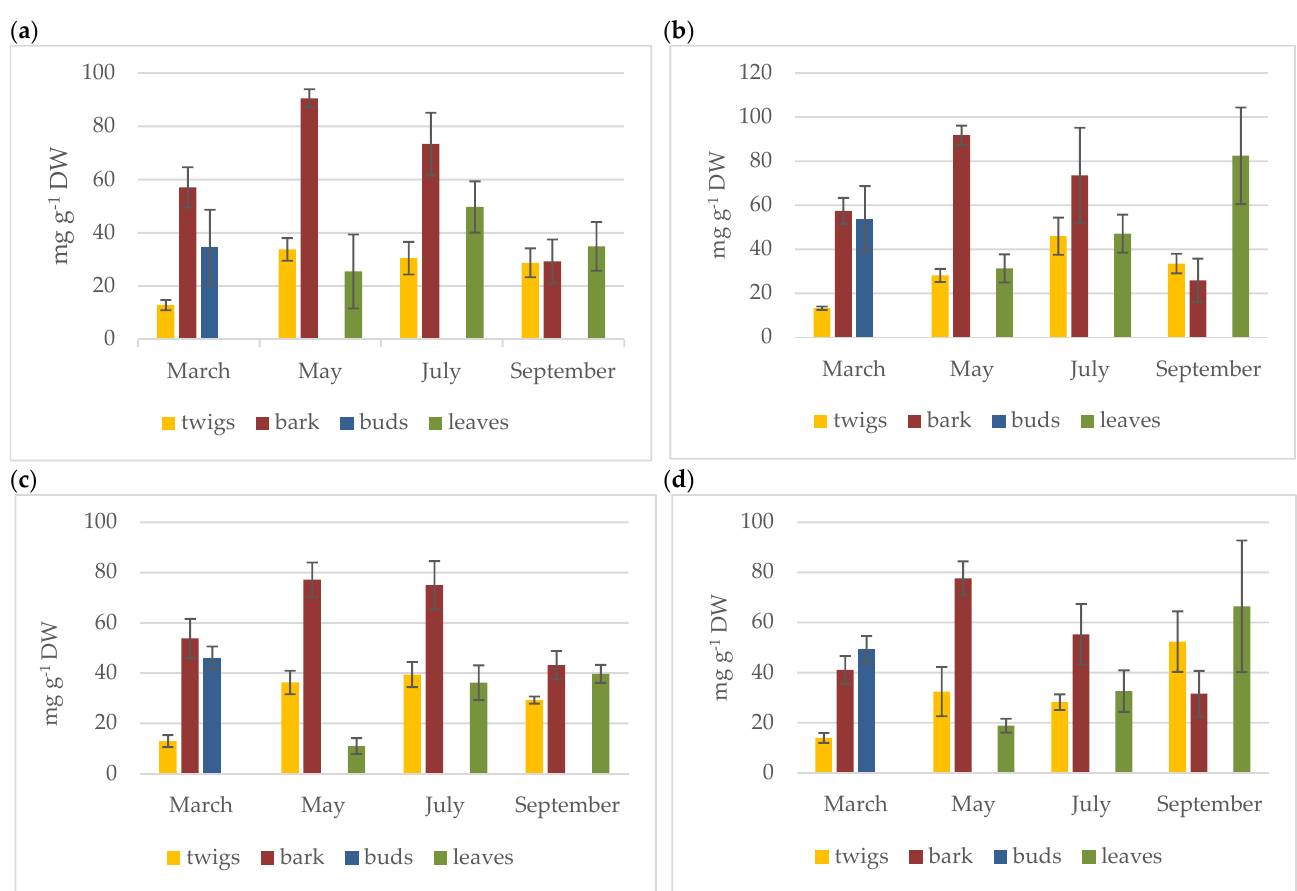
Figure 3. Content of phloridzin in ( a ) cv. ‘Jonagold’, ( b ) cv. ‘Opal’, ( c ) cv. ‘Redlane’, ( d ) cv. ‘Rozela’ during the vegetation period ( n = 5).